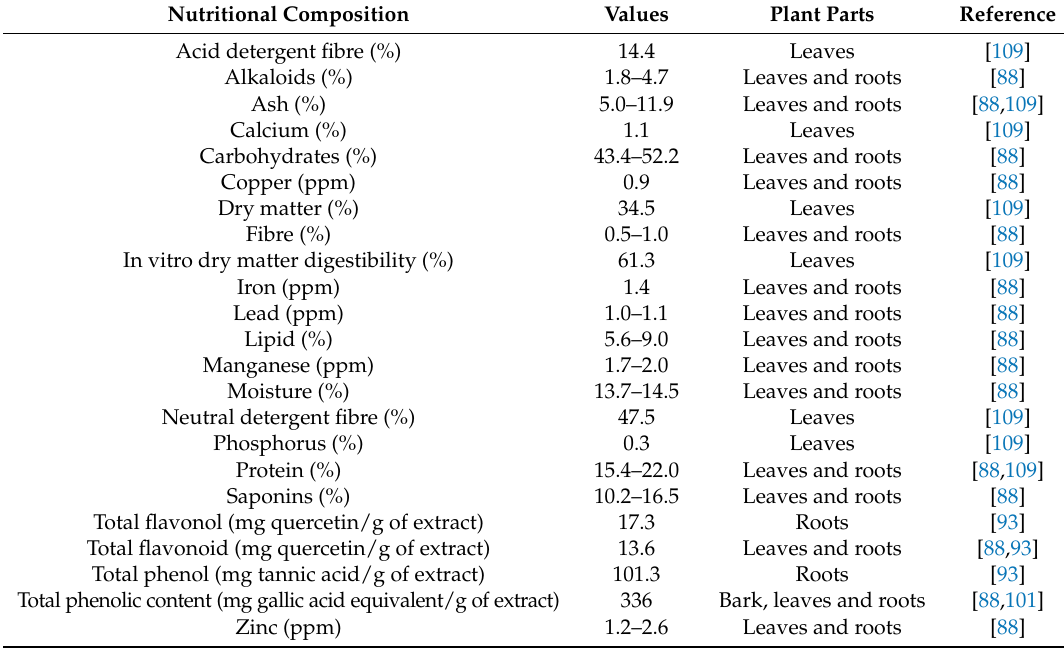
Table 2. Nutritional and phytochemical composition of roots of Lannea schweinfurthii . Nutritional